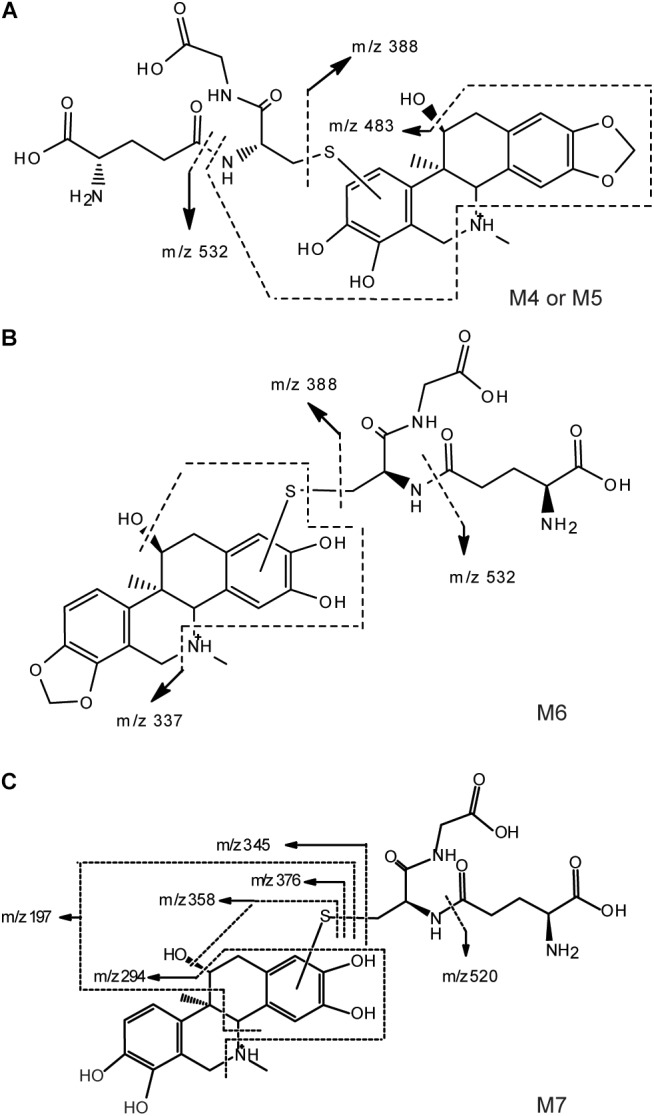
Proposed structure and fragmentation pathways of M4, M5 (A), M6 (B) and M7 (C).